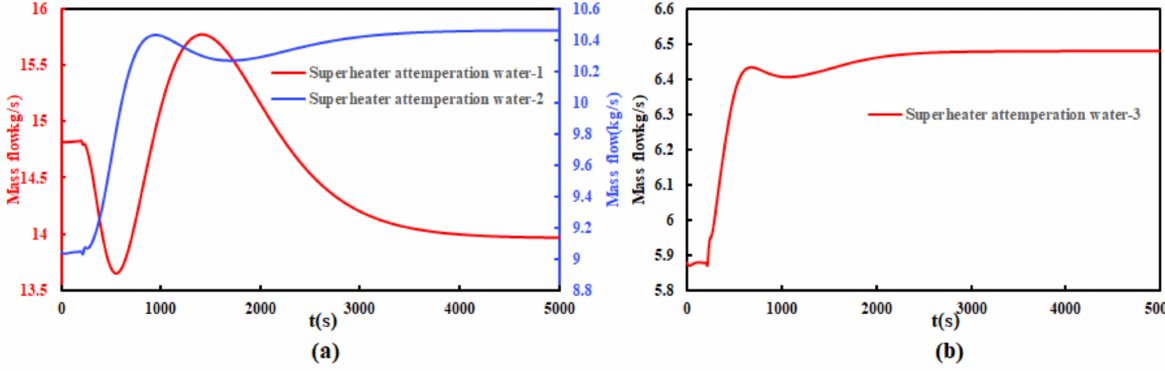
Figure 14. Attemperation water system response when total air mass flow decreased by 5%: ( a ) superheater attemperation water-1 and superheater attemperation water-2 mass flow; ( b ) superheater attemperation water-3 mass